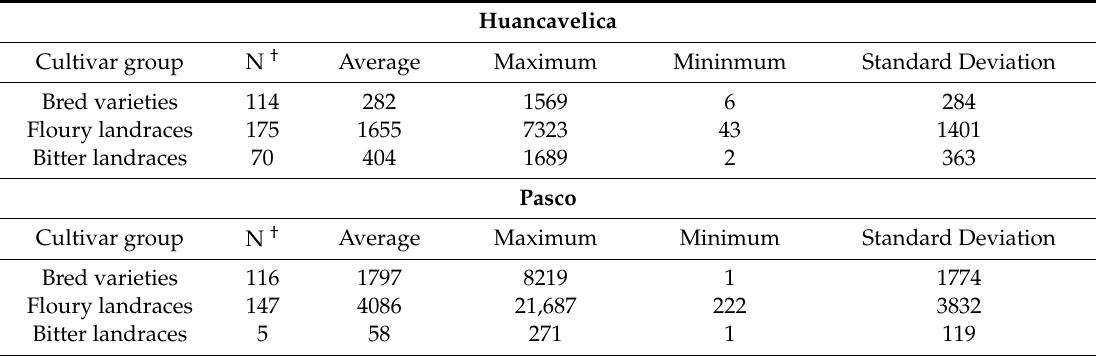
Table 9. Average total cropping area (m 2 ) per household by cultivar group and landscape. Huancavelica